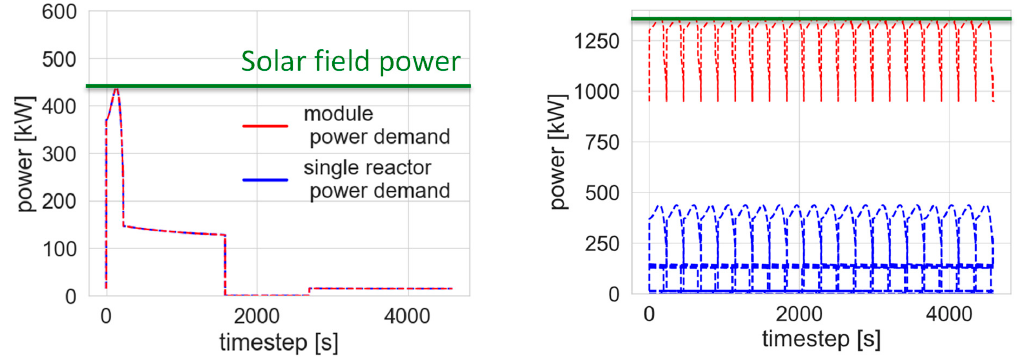
Figure 4. Heat requirement of a single nickel-ferrite reactor ( left ), and of a module ( right ) during a complete cycle.